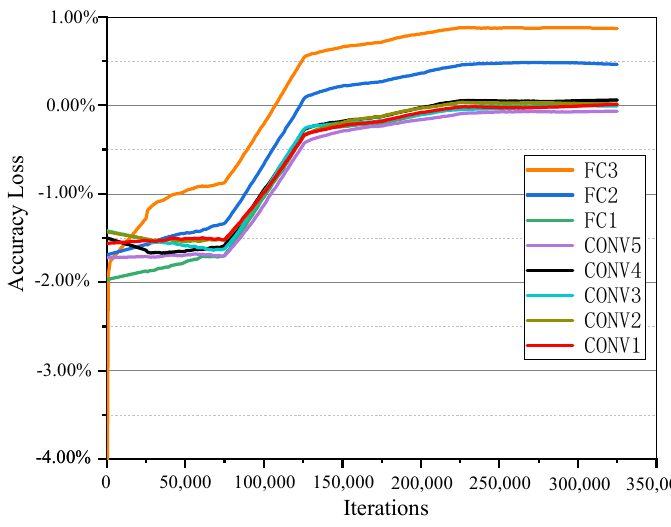
Figure 4. Top-1 accuracy loss of AlexNet in